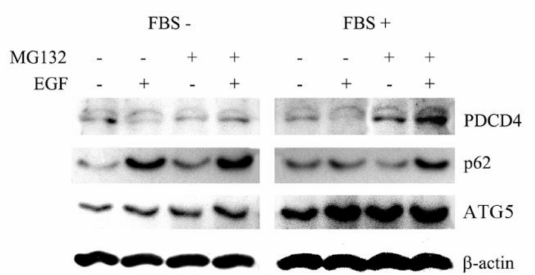
Figure 1. EGF (epidermal growth factor) upregulated the PDCD4 (programmed cell death 4) levels in the presence of MG132. Huh7 cells were cultured for 4 days and treated for 4h with or without 20 µ g / mL EGF in the presence or absence of 20 µ M MG132 under normal ( + FBS) and serum-depleted (-FBS) culture conditions. The treated cells were then subjected to Western blotting analyses. Experiments were repeated at least three times and similar results were obtained from each experiment. A representative result is shown in the